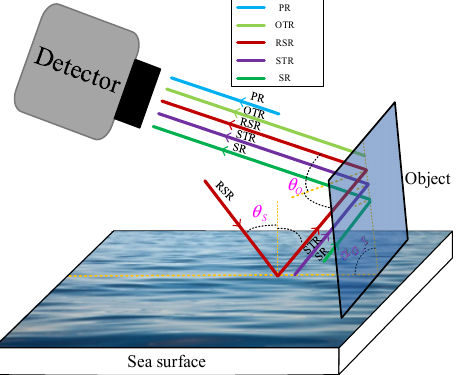
θ θ and are the observation O S α is the angle between the object and the sea sur- _ O S